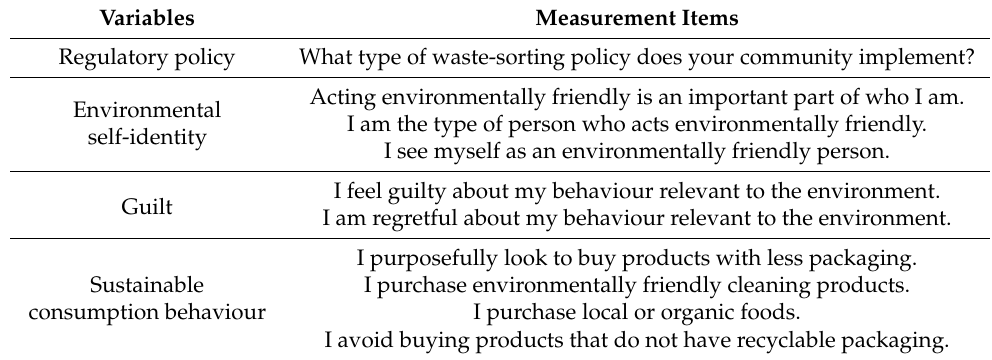
Table A1. Description of measurement